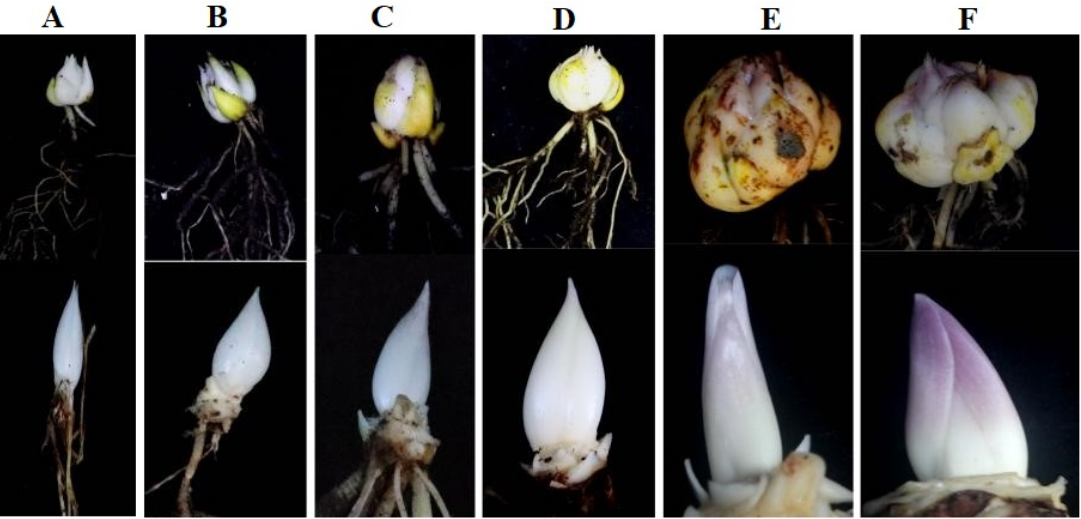
Figure 1. The appearance and morphology of Lilium bulb and bud at different developmental stages ( A – F ). ( A ) The bulb diameter is 3 cm; ( B ) the bulb diameter is 6 cm; ( C ) the bulb diameter is 10 cm; ( D ) the bulb diameter is 14 cm; ( E ) the bulb diameter is 16 cm; ( F ) the bulb diameter is 22 cm. The data represent the average of three biological replicates.